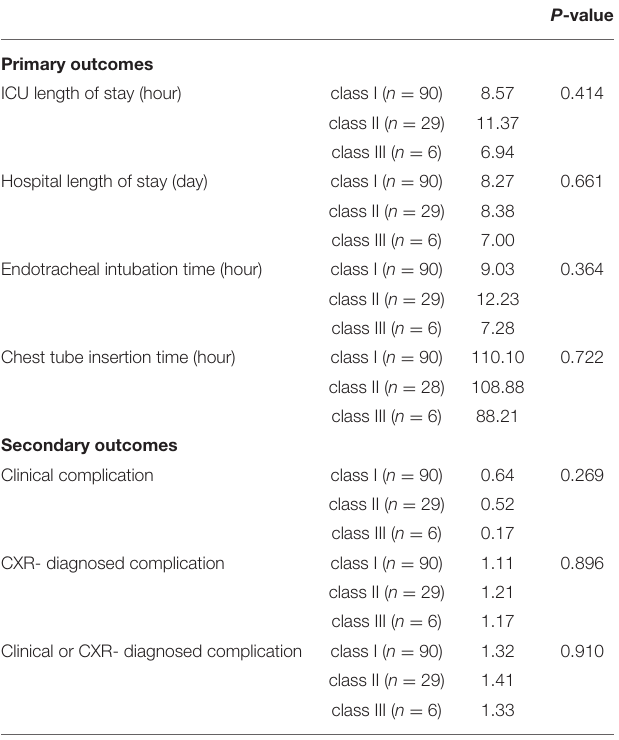
TABLE 3C | Outcomes comparisons by slope of minute ventilation and carbon dioxide production (V E /V CO2 slope).